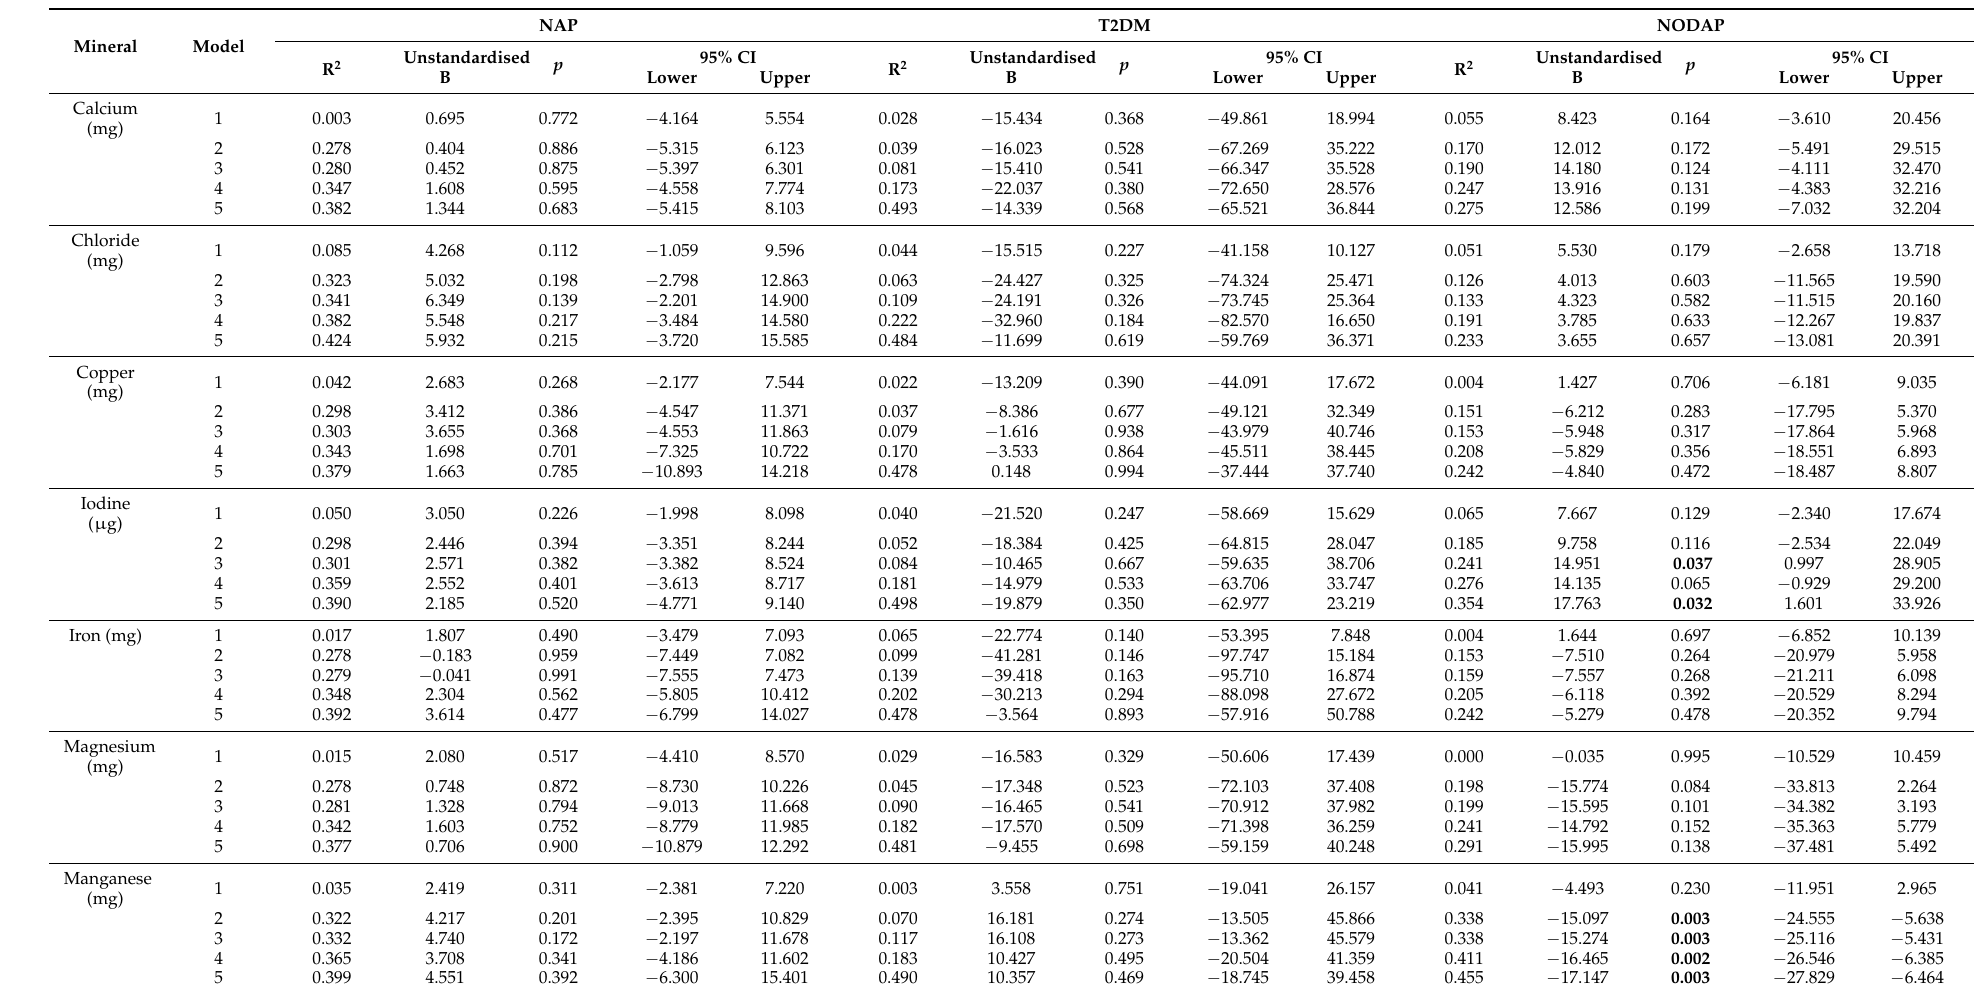
Table 3. Associations between habitual mineral intake and HbA1c in the study